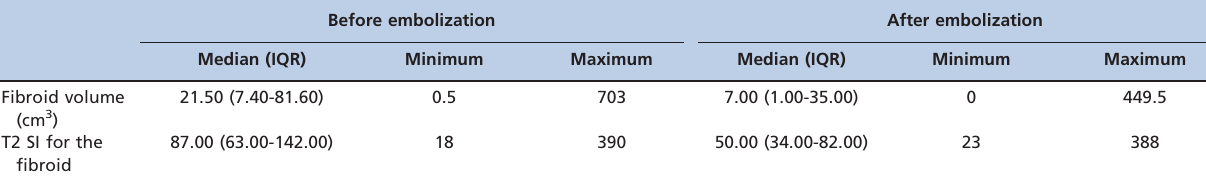
Table 2 - Measurement of the fibroid volume and T2 signal intensity before and after embolization.